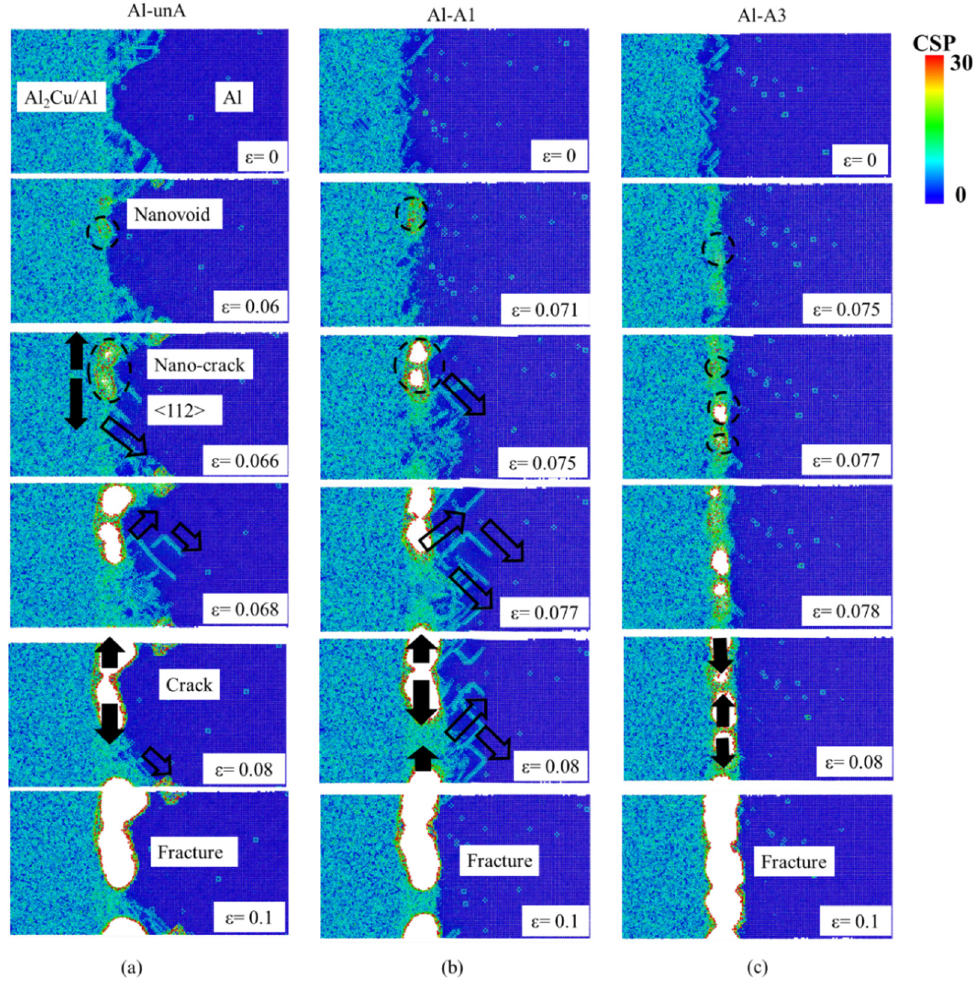
Figure 12. CSP analyses for ( a ) Al-unA, ( b ) Al-A1, and ( c ) Al-A3 at different strain values. (The unfilled arrows denote the dislocation propagation direction, and filled arrows denote the crack propagation direction.)